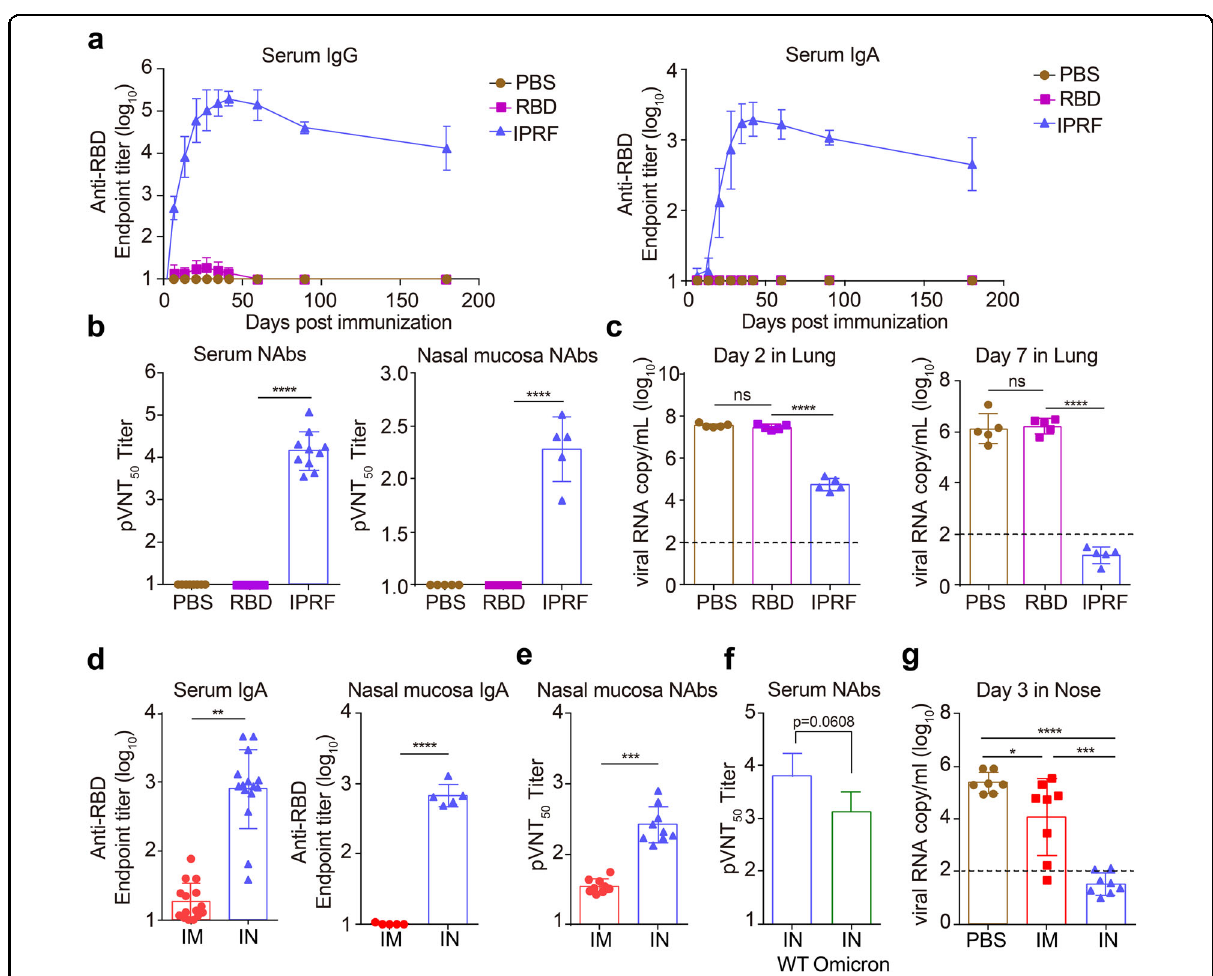
Fig. 1 Intranasal administration of IPRF-induced robust IgG and IgA responses against SARS-CoV-2. C57BL/6 mice ( n = 10) were i.n. immunized with 10 μ g IPRF, equal molar of RBD, or PBS. a Antibody levels in sera of immunized mice were evaluated weekly after prime and boost vaccination. b The viral neutralization antibody titer (NAbs) of vaccinated sera and nasal mucosal collected on day 42 was evaluated using a pseudovirus neutralization assay. c The hACE2-transgene mice ( n = 10) were i.n. immunized with 10 μ g IPRF, equal molar of RBD or PBS twice on days 0 and 14. Mice were challenged with authentic SARS-CoV-2 6 weeks post the boost dose. Five mice in each group were euthanized 2 days post challenge. The other fi ve mice in each group were euthanized 1 week post challenge. Viral RNA copies in the lung of each mouse were determined by qRT-PCR and plotted as log10 copies per mL. d – f C57BL/6 mice ( n = 10) were i.n. or i.m. immunized with 10 μ g IPRF. d RBD-speci fi c IgA response in sera and nasal mucosal homogenate supernatant on day 42 was measured by ELISA. e Vaccinated mouse nasal mucosal collected on day 42 was evaluated using a WT pseudovirus neutralization assay. f The neutralization activity was evaluated using an Omicron pseudovirus neutralization assay. g The hACE2-transgene mice ( n = 8) were i.n. or i.m. immunized with 10 μ g IPRF or PBS twice on days 0 and 14. Mice were challenged with authentic SARS-CoV-2 12 weeks post the boost dose. Mice in each group were euthanized 3 days post challenge. Viral RNA copies in the nasal of each mouse were determined by qRT-PCR and plotted as log10 copies per mL. The data shown are presented as mean ± SEM. P values were determined by one- way ANOVA with multiple comparison tests. ns, not signi fi cant; * P < 0.05, ** P < 0.01, *** P < 0.001, **** P <